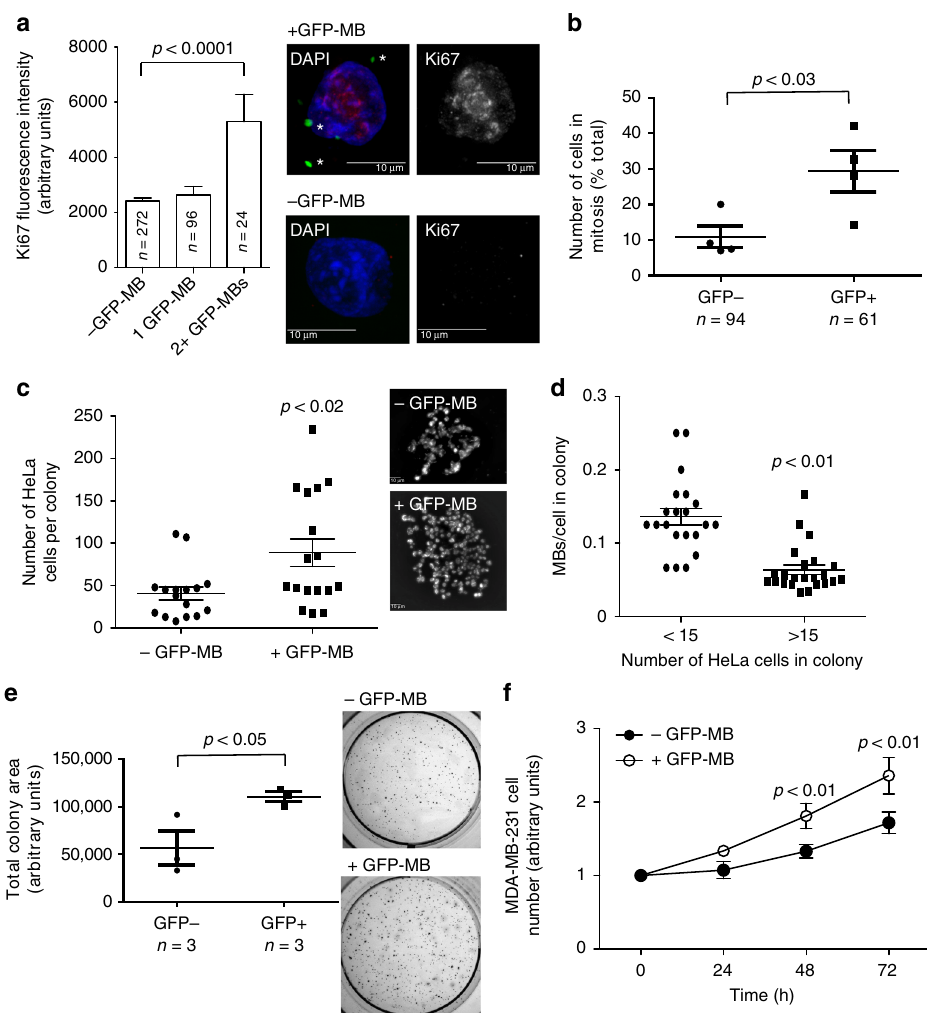
Fig. 2 Post-abscission MB internalization stimulates cell proliferation. a, b HeLa cells were incubated with puri fi ed GFP-MBs for 3 h, followed by wash and incubation for another 24 h. Cells were then fi xed and stained with anti-Ki67 ( a ) or anti-acetylated tubulin ( b ). Panel a shows quanti fi cation of Ki67 levels in each cell, while panel b shows quanti fi cation of the percentage of cells in mitosis (as determined by the presence of mitotic spindle). Data shown are the means and standard deviations derived from 200 randomly chosen cells from three independent experiments for Ki67 staining and four independent experiments for mitotic index quanti fi cation (Student ’ s unpaired, two-tailed t -test). Asterisks in images ( a ) mark post-abscission MBs. n shows the number of cells analyzed for each condition. c Hela cells stably expressing mCherry-CAAX were fed MBs and GFP-MB + cells were identi fi ed by fl uorescence microscopy. Unfed cells were used as a control. Cells were tracked using glass bottom dishes and were then tested for their proliferative capacity by imaging the same cell 7 days post feeding. Data shown are the means and standard deviations derived from four independent experiments (Student ’ s unpaired, two-tailed t -test). d HeLa cells were plated at low density and grown for 72 h to form colonies. Cells were then incubated for 3 h with puri fi ed GFP-MBs. The ability to internalize MBs by fast dividing cells (formed large colonies) was then compared to slow dividing cells (formed small colonies). Data shown are the means and standard deviations derived from three independent experiments (Student ’ s unpaired, two-tailed t -test). e Hela cells